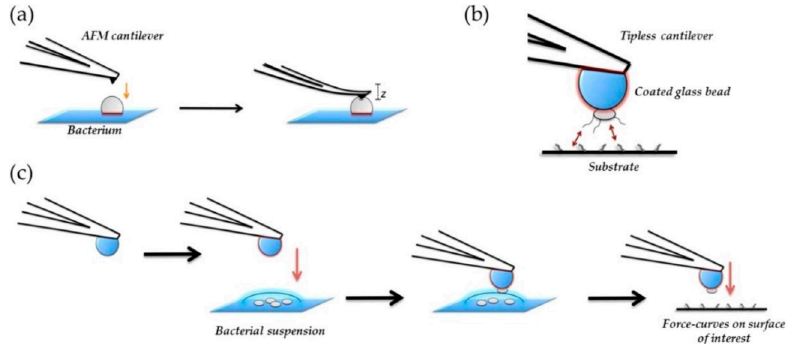
Figure 14. Schematic representation of bacterial nanomechanics experiments for ( a ) nanoindentation and ( b ), and ( c ) single-cell force spectroscopy (SCFS). In nanoindentation Table 2015. NanoTable 26. 062,001